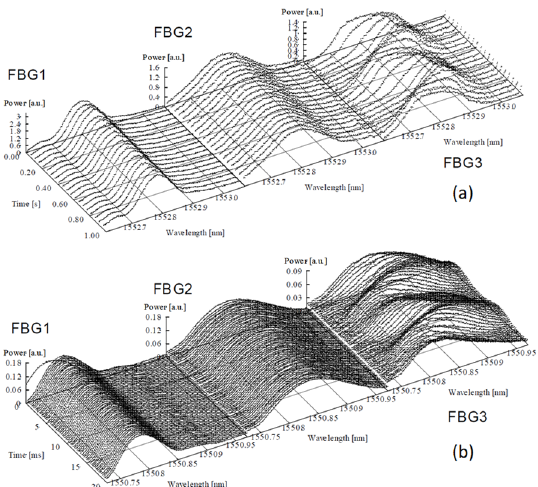
Figure 10. Example of optical setup for multiplexed sensing of fiber Bragg gratings (FBGs) that have the same Bragg wavelength with the SOCF technology [28].